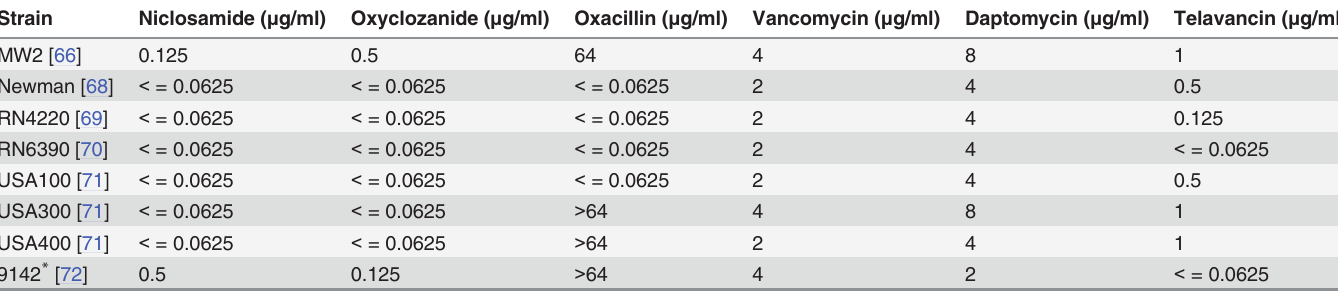
Table 2. Antibacterial activities of niclosamide and oxyclozanide against staphylococcal strains.